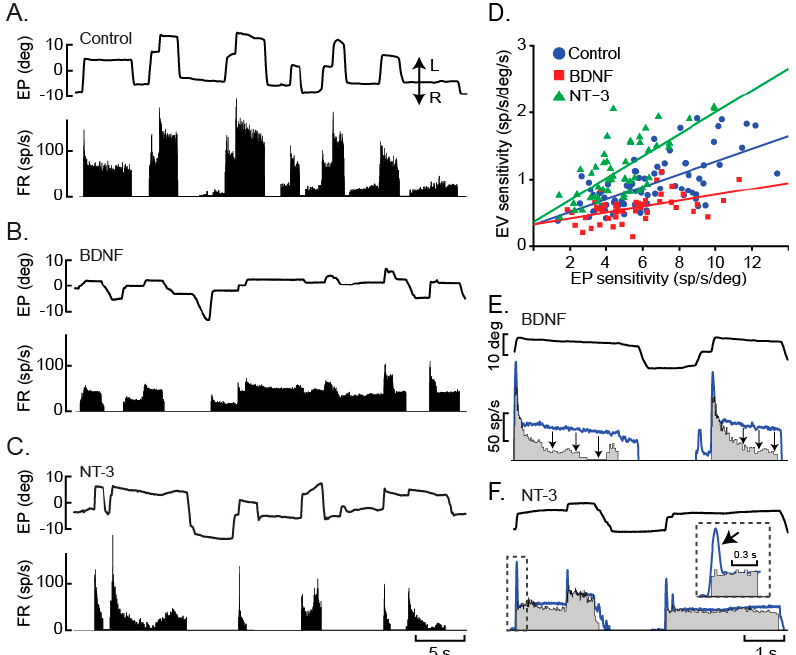
Figure 5. Complementary firing patterns of BDNF- and NT-3-treated motoneurons: ( A ) The firing rate (FR, in spikes/s; sp/s) of control motoneurons shows burst for on-directed saccades and a tonic activity during eye fixations; ( B ) treatment with BDNF for eight days immediately after axotomy reduced bursts in response to saccades; ( C ) same as ( B ) but for a seven-day NT-3-treated cell displaying large bursts for saccades but reduced tonic firing for eye fixations; ( D ) relationship between neuronal eye position (EP, in degrees; deg) and eye velocity (EV) sensitivities obtained by linear regression analysis for 75 control ( blue ), 45 BDNF-treated ( red ) and 51 NT-3-treated ( green ) motoneurons showing that BDNF recovered the tonic (EP), whereas NT-3 restores the phasic (EV) component of discharge activity; and ( E ) response of a motoneuron ( grey firing rate) NT-3-treated for 14 days immediately after axotomy. The blue line represents the firing rate simulation expected for the actual eye movement. Arrows point to the decay in firing rate during fixations; ( F ) Response of a BDNF-treated motoneuron ( grey ) for 24 days demonstrating a tonic mode of firing. The blue line as in ( E ) represents the simulated firing expected for the actual eye movements. The arrow points to the reduced bursts during saccades that are characteristic of BDNF-treated cells that, however, exhibit normal tonic firing. Taken from [105].